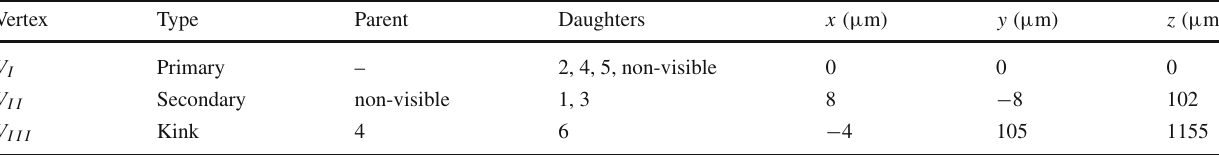
Table 2 Position of the reconstructed vertices inside the brick evaluated with respect to the primary vertex V I . A particle fully contained in the lead (non-visible) is associated with vertex V I and it is the parent of vertex V II